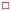
Changes in diffusion properties in cortical gray matter during hydrocephalus development.Diffusion properties of the cortical gray matter of hydrocephalic rats (□) had a (a) higher mean diffusivity than controls (□) at day sixteen and (b) lower fractional anisotropy than controls (□) from day seven. The upper cortical gray matter region in the presence of enlarged ventricles had (c) the same mean diffusivity as controls but a (d) lower fractional anisotropy from day three. P values for significance of the interaction between groups in the RM ANOVA tests and significant Sidak’s comparisons are reported for each graph.